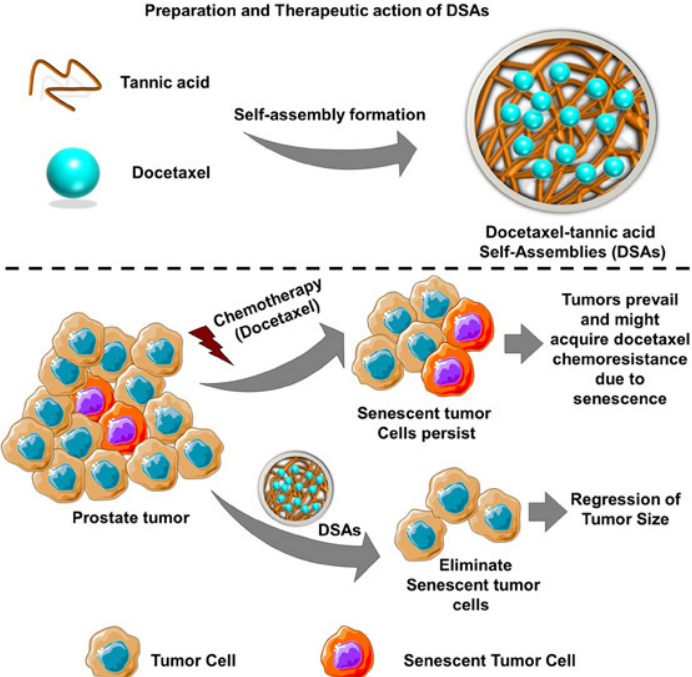
Figure 3. Schematic representation of DSA preparation and the antisenescence mechanism of DSAs in prostate cancer. (DSAs: Docetaxel − tannic acid self-assemblies). Reprinted with permission from Ref. [81]. Copyright 2019 American Chemical Society.